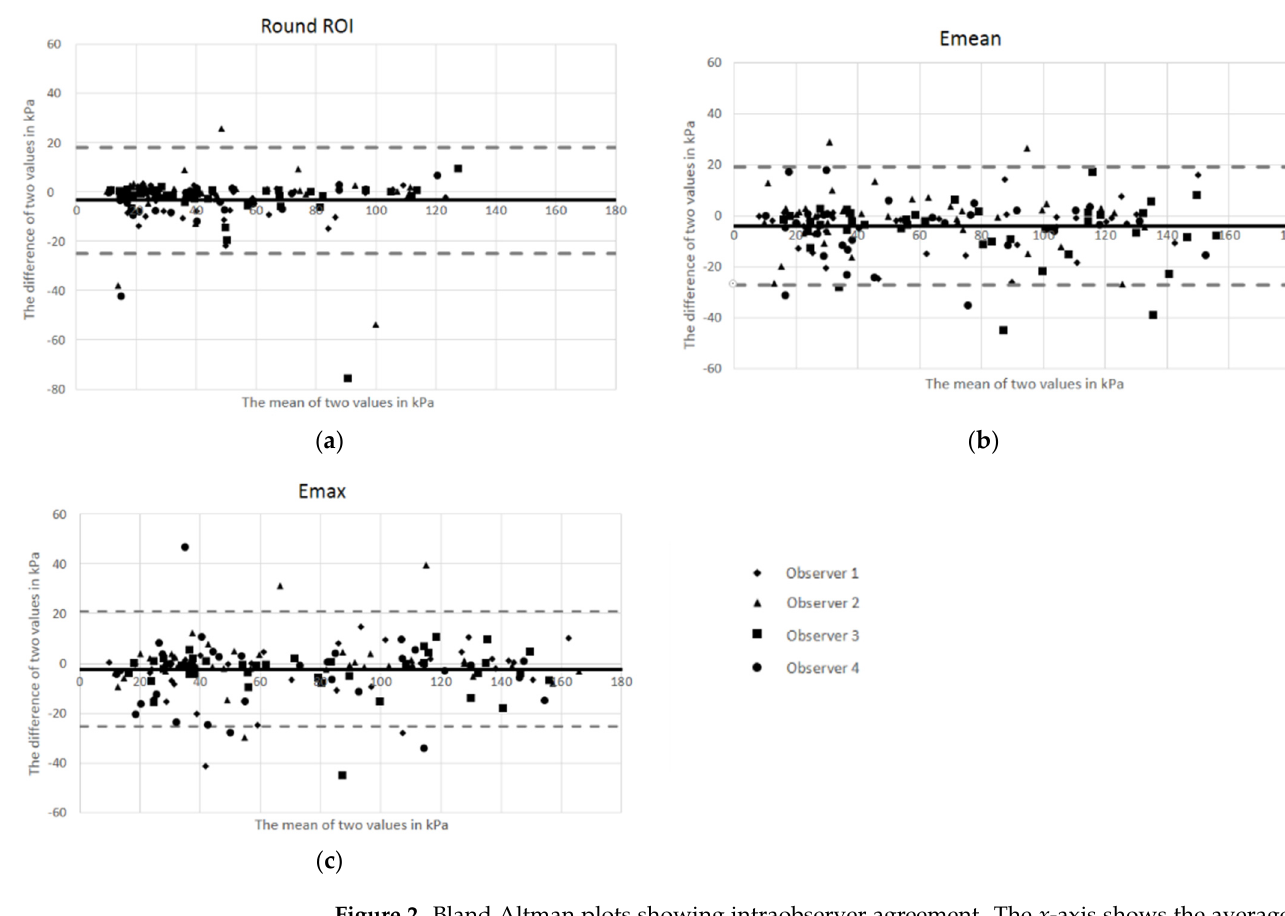
Figure 2. Bland Altman plots showing intraobserver agreement. The x -axis shows the average of reads 1 and 2, and the y -axis gives the mean of the two reads. The solid horizontal line corresponds to the mean difference (bias). The dotted horizontal lines represent the limits of agreement (LoA): ( a ) Round ROI, elastography value of a round region of interest (ROI) with a diameter of 1 cm; ( b ) Emean, the mean of three small ROIs; ( c ) Emax, the maximum elastography value of three small ROIs.